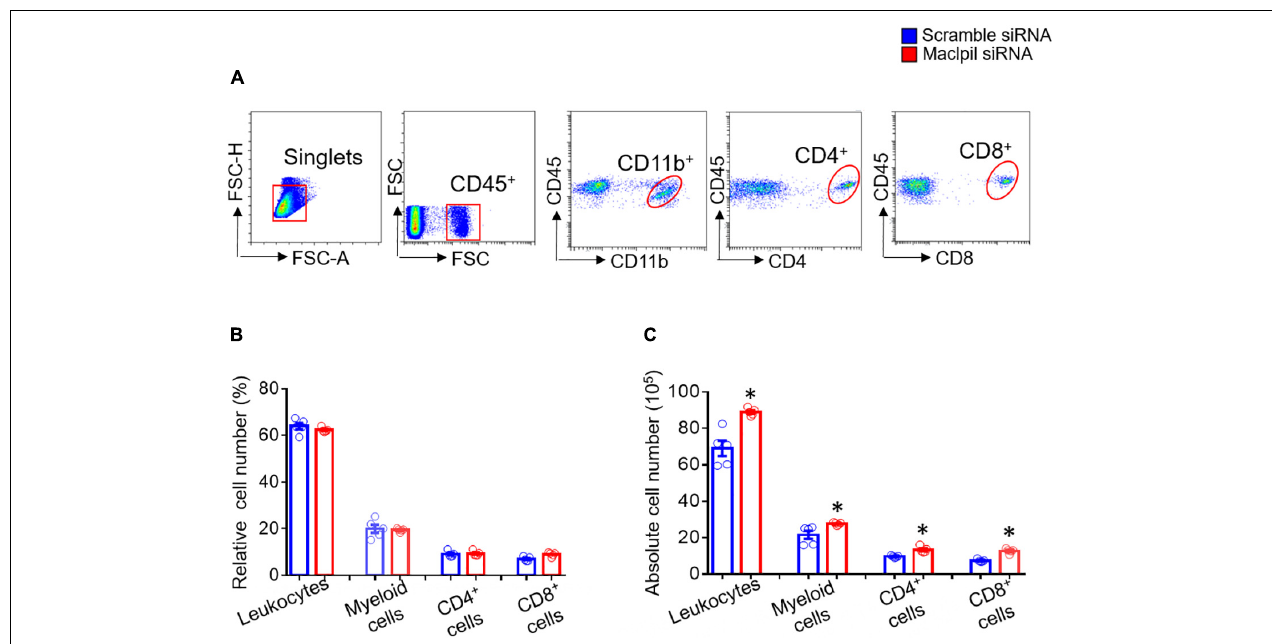
FIGURE 4 | siRNA silencing Maclpil increases circulating leukocytes in experimental ischemic stroke. (A) Flow cytometric analysis strategies for identifying individual subsets of leukocytes. Leukocytes: CD45 + ; myeloid cells: CD45 + CD11b + CD45 low ; CD4 + cells: CD4 + ; and CD8 + cells: CD8 + . (B,C) Quantification of relative (B) and absolute (C) numbers of leukocytes, myeloid cells, CD4 + cells and CD8 cells. All data are given as mean and SD from 5 mice per group. Student’s t -test, ∗ p < 0.05 compared to scramble siRNA treatment.